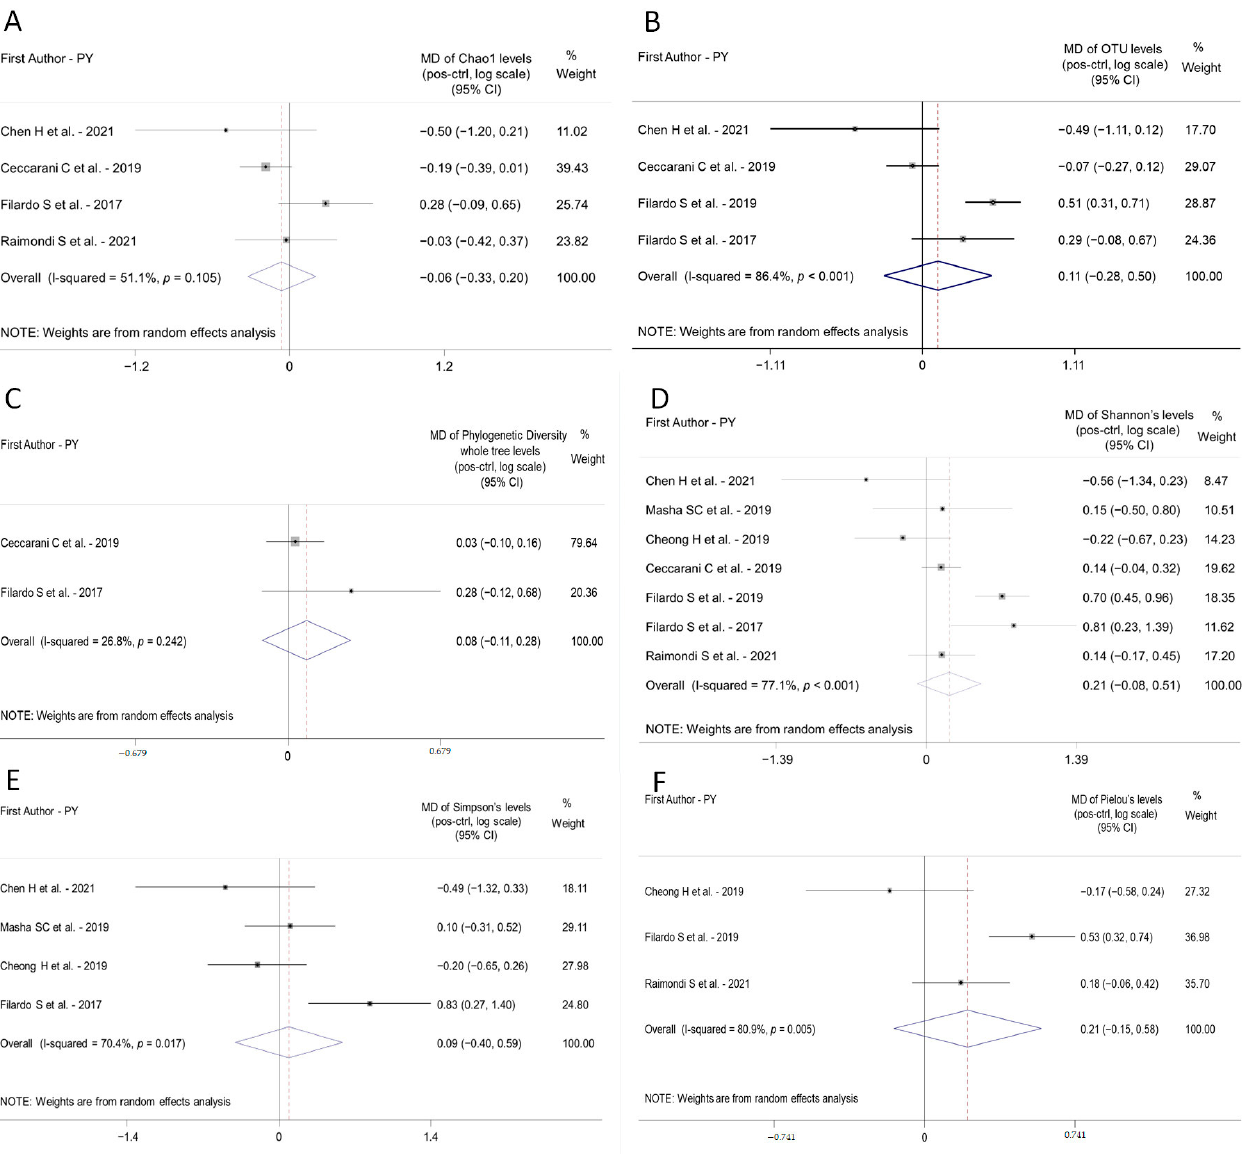
Figure 2. Forest plot displaying the results of the meta-analyses of studies reporting data about each Alpha-Diversity parameter in the positive group (pos) and healthy controls (ctrl). ( A ), Chao1; ( B ), OTU number; ( C ), Phylogenetic diversity whole tree; ( D ), Shannon; ( E ), Simpson; ( F ), Pielou’s evenness). The point estimated by each study (Mean Difference on logarithmic scale between pos and ctrl, MD) is represented by a square and the horizontal line is the 95% Confidence Interval (95% CI). The area of the square reflects the weight that the study contributes to the meta-analysis. The combined-effect MD and its 95% CI are represented by the diamond. The vertical line represents the line of no difference. CI, confidence interval; MD, Mean Difference; PY, Publication Year. See Refs. [22–28].